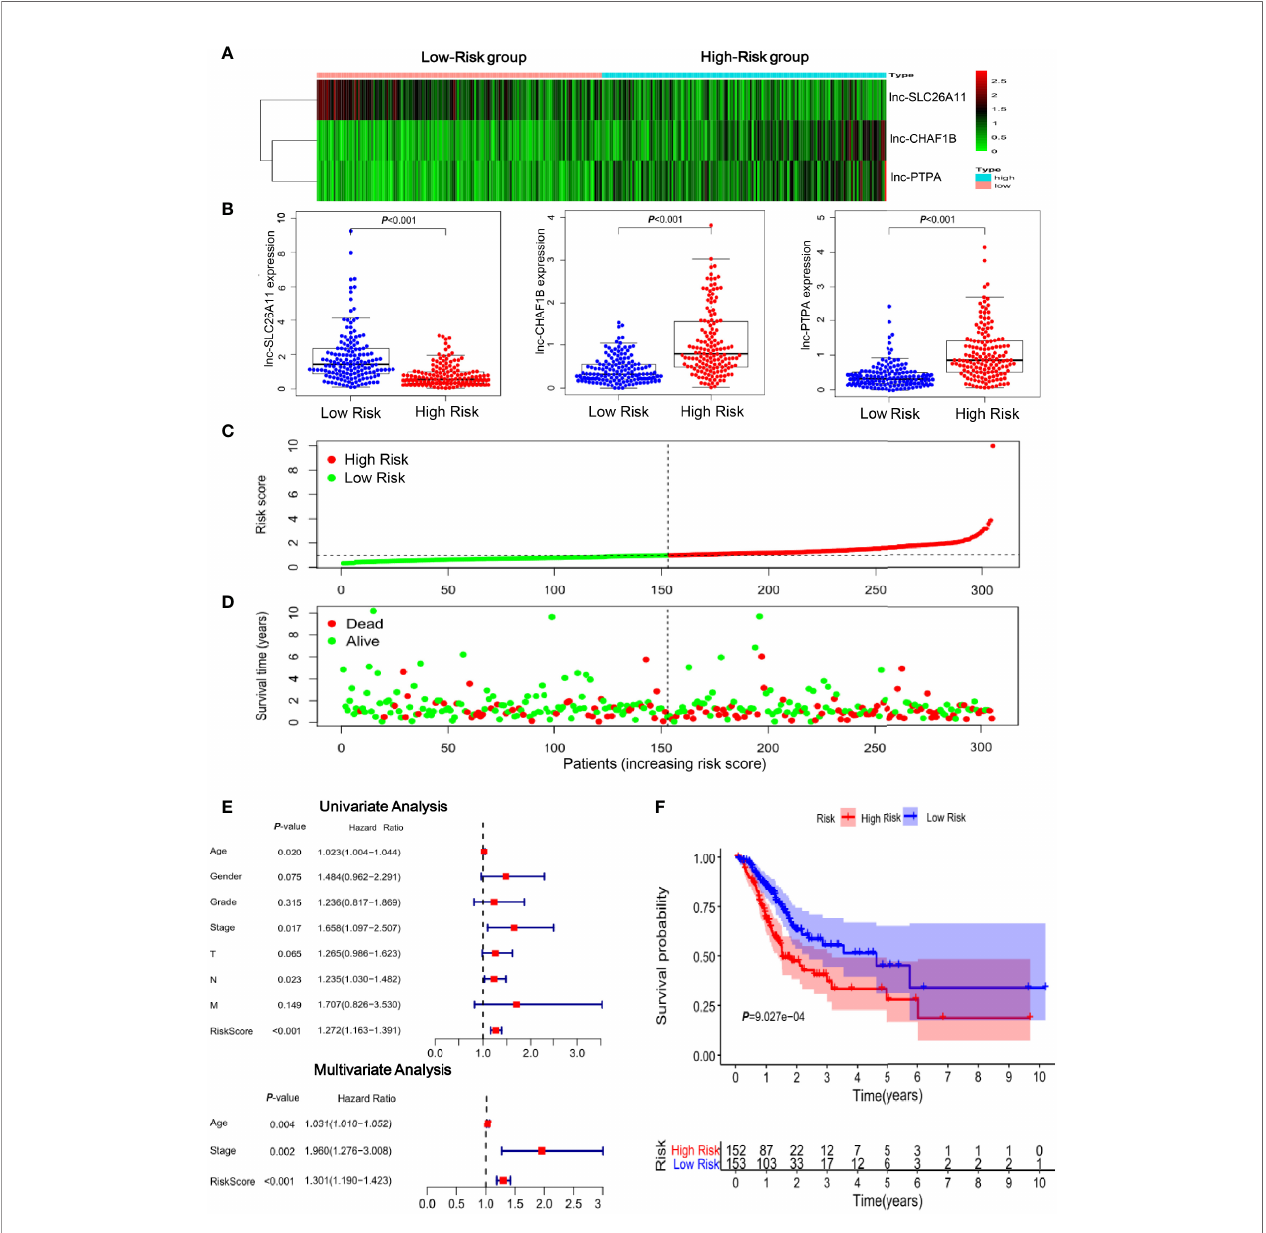
FIGURE 2 | Clinical signi fi cance of the immune-related lncRNAs in gastric cancer. (A) Heatmap of the three-lncRNA panel. Each column represented a patient. (B) The expression levels of the three lncRNAs in gastric cancer samples in TCGA database. (C) Risk score distribution according to the immune-related lncRNA pro fi le in TCGA gastric cancer samples. (D) The association of risk score and survival status. (E) Forest plot of the univariate and multivariate analysis results showed that the risk score could serve as an independent prognostic indicator. (F) Kaplan-Meier curves of the overall survival time for high- and low risk patients in TCGA gastric cancer